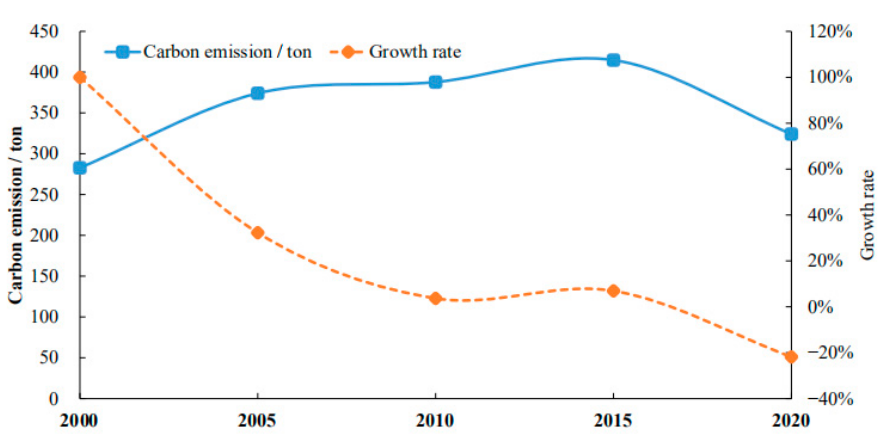
Figure 2. Time series change of total amount and growth rate of carbon emission.